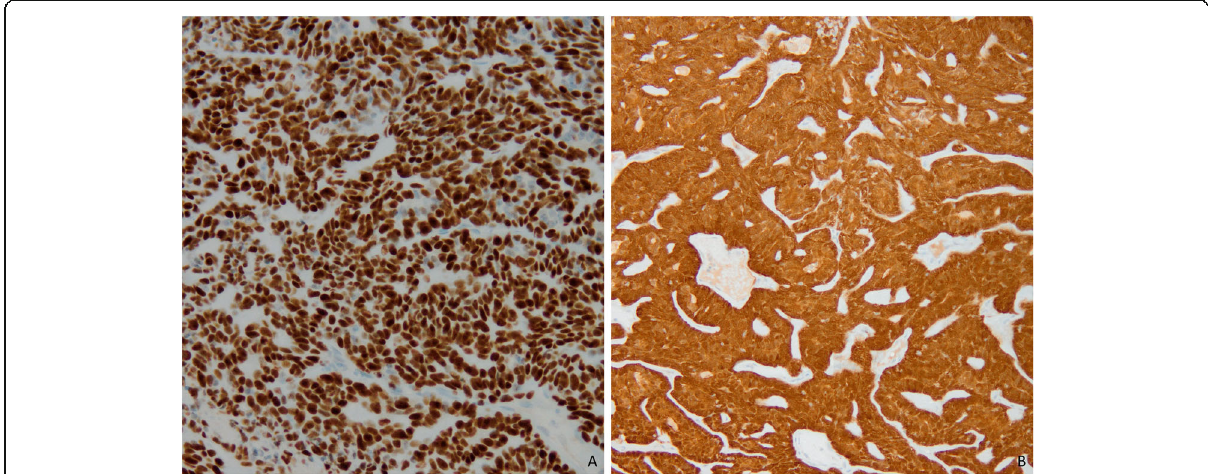
Fig. 2 a . Strong nuclear expression of p53 mutation in tumor cells with mutation of TP53 gene by NGS. b . Strong nuclear and cytoplasmic expression of p16 protein in tumor cells with no association with